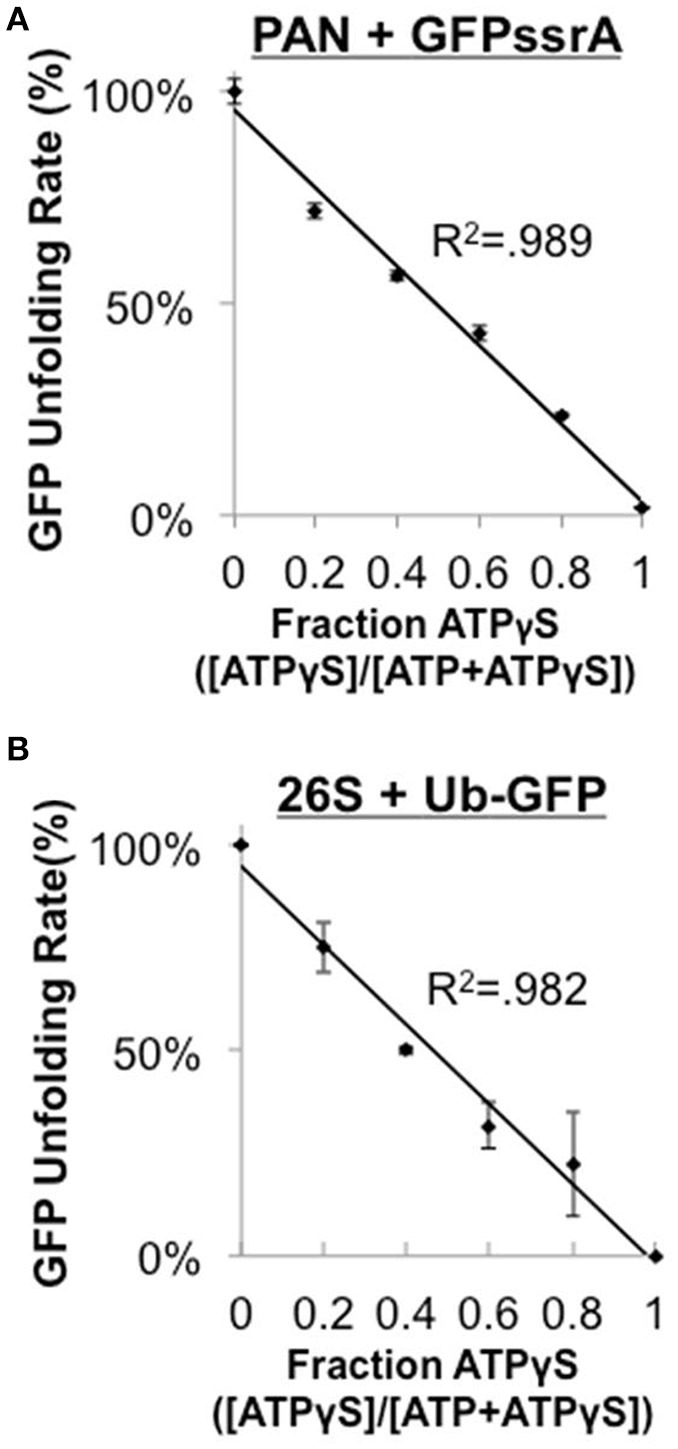
The eukaryotic 26S does not stall when it encounters the folded domain of GFP. (A) PAN's ATPase rate was slowed by competing with increasing ratios of ATPγS:ATP (2 mM total nucleotide), and GFPssrA (0.2 μM) unfolding rate was assessed as in Figure 1A. Data fit a line with an R2 = 0.989. (B) 25 nM of purified rabbit 26S was incubated with 100 nM Ub4(lin)-GFP35 and was analyzed as in (A). Data fit a line with an R2-value of 0.982. “Stalling” is defined in Figure 2. Error bars are standard deviations from three independent experiments (n = 3).